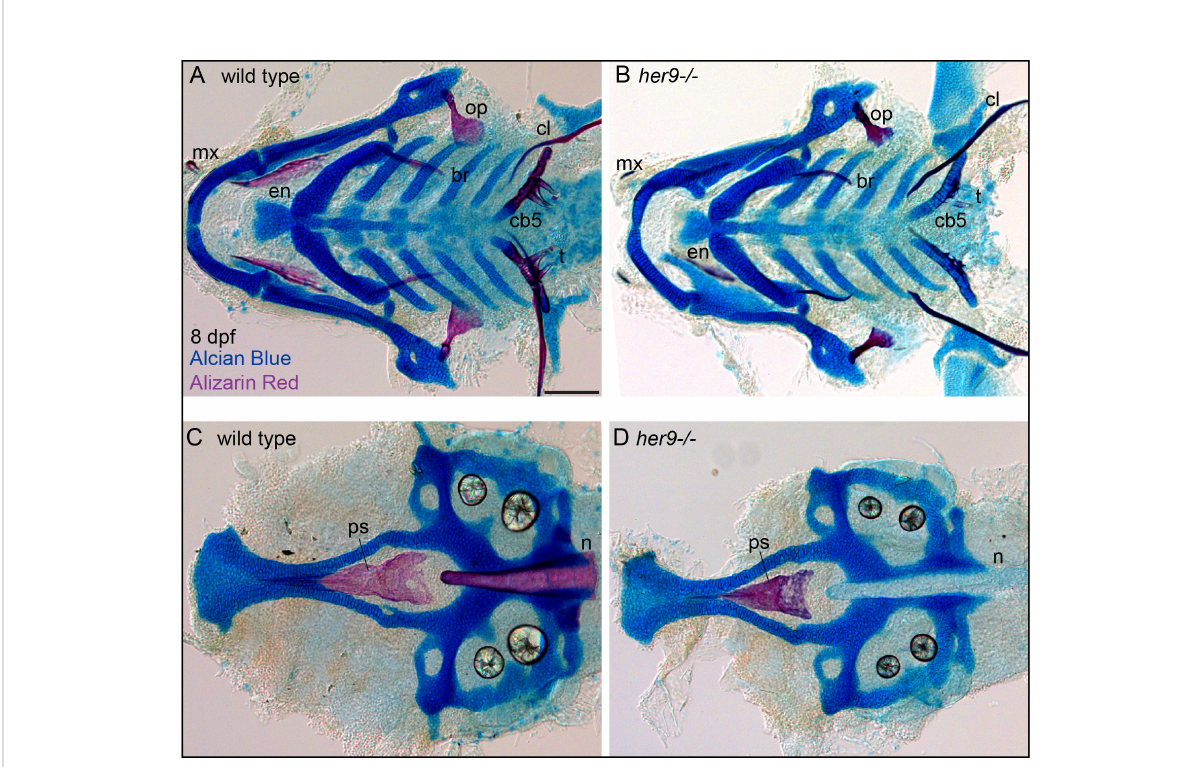
FIGURE 3 Mineralization defects in her9 homozygous mutants partially recover at late stages of larval development. Zebra fi sh heterozygous for her9 were pairwise intercrossed and at eight days post fertilization (dpf) larvae were stained with Alcian Blue and Alizarin Red to label cartilage and bone. The individuals were then genotyped, the viscerocrania and neurocrania were dissected, fl at mounted, and then imaged. (A, B) Viscerocrania from wild-type and her9 homozygous mutant larvae. (C, D) Neurocrania from wild-type and her9 homozygous mutant larvae. The following craniofacial elements are indicated: opercle bone (op), branchiostegal ray (br), maxilla (mx), entopterygoid (en), ceratobranchial 5 (cb5) bone, teeth (t), cleithrum (cl), parasphenoid bone (ps), and notochord (n). Scale bar is 100 m